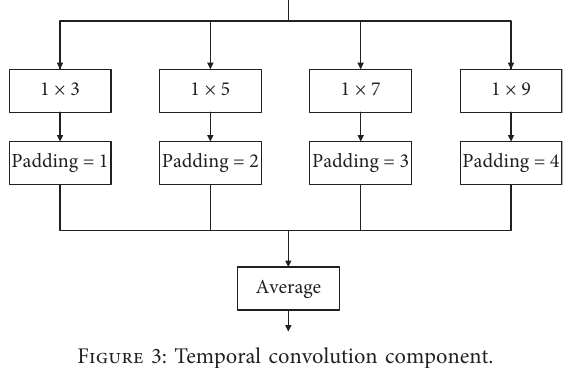
Figure 3: Temporal convolution